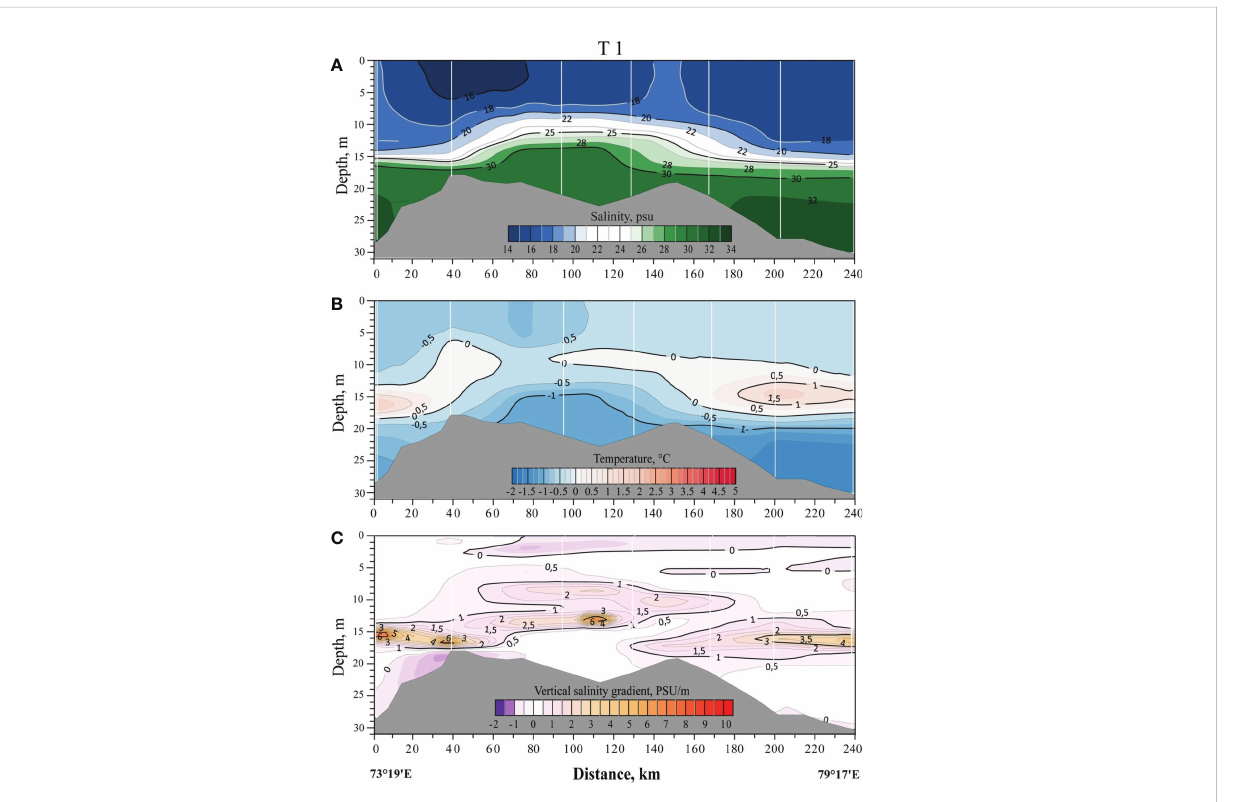
FIGURE 3 Vertical distribution of salinity (A) , temperature (B) , and vertical salinity gradient (C) along transect T1 on 25-26 October